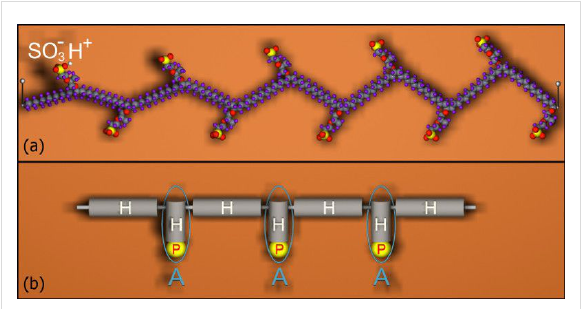
Figure 2: (a) Fragment of a Nafion chain with sulfonic acid groups in dissociated state. The side chains are periodically separated by 15 CF 2 groups ( m = 7 in Figure 1a). This corresponds to an average equivalent weight (EW) of Nafion, which is about 1150 g/mol (EW is defined by the number of grams of dry Nafion per mole of sulfonic acid groups, when the material is in the acid form, and is given by the rela- tion EW = 100 m + 446). A 1100 EW holds for the standard commer- cialized Nafion 117. All sulfonic acid groups of Nafion are supposed to be in dissociated state. (b) Schematic representation of Nafion as a hydrophobic-hydrophilic copolymer with amphiphilic (A) units. Hydro- philic (P) sites are depicted in yellow and hydrophobic (H) chain sections are shown in gray. Connected H and P groups are consid- ered as an amphiphilic HP